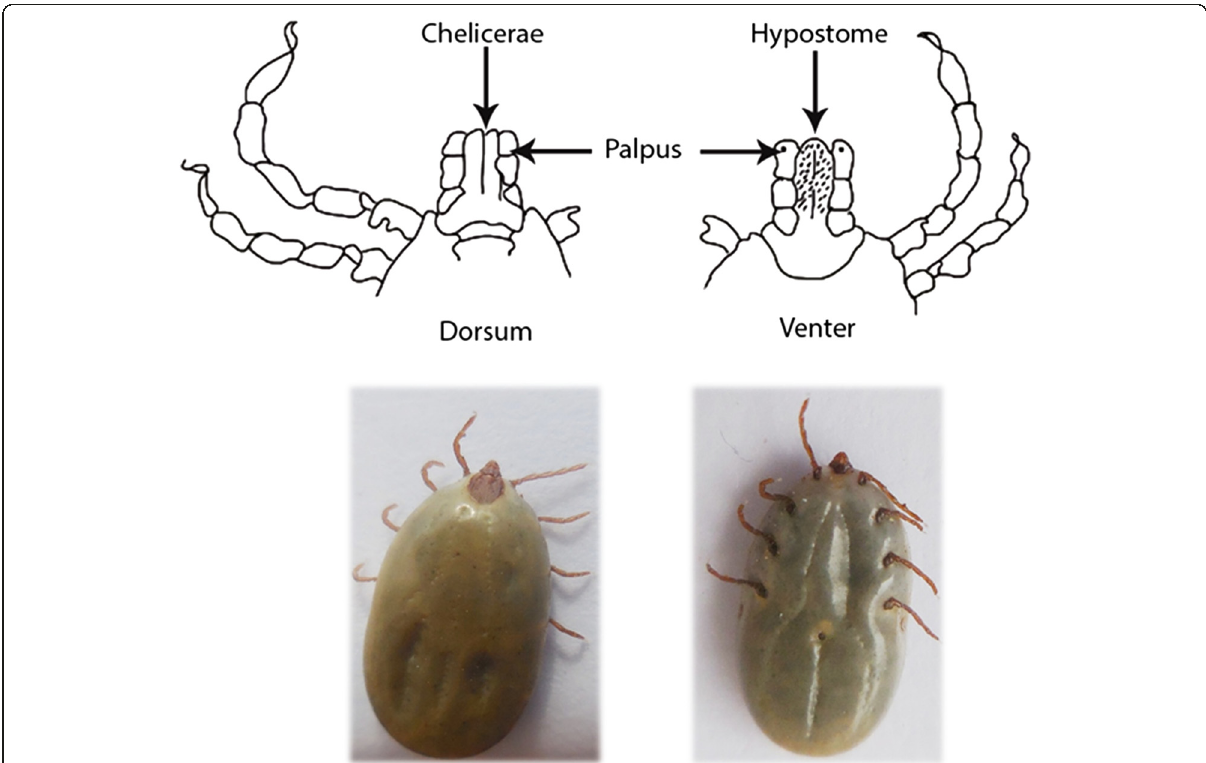
Fig. 4 Photo of a tick and schematic representation of the capitulum . Dorsal and ventral morphology of the mouthpart of Ixodidae family ticks. On the dorsum it is possible to observe the chelicerae while the venter displays the hypostome. The palpus is observable on both sides (dorsum and venter). The hypostome is responsible for the dermal and epidermal damage (rupture of local blood vessels) during the tick ’ s